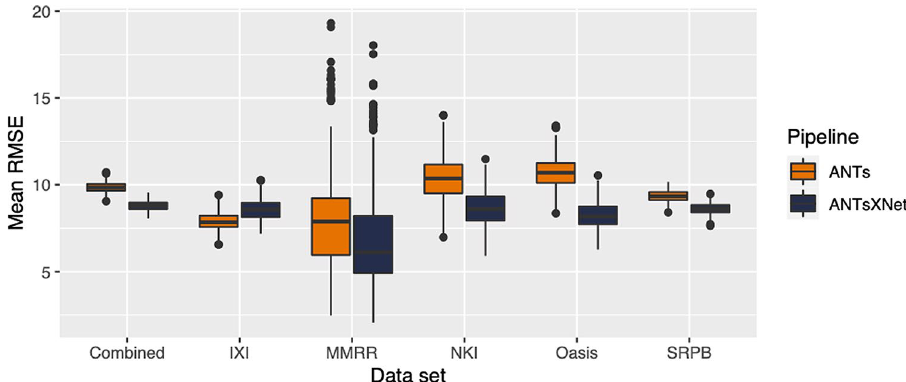
Figure 3. Distribution of mean RMSE values (500 permutations) for age prediction across the different data sets between the traditional ANTs and deep learning-based ANTsXNet pipelines. Total mean values are as follows: Combined—9.3 years (ANTs) and 8.2 years (ANTsXNet); IXI—7.9 years (ANTs) and 8.6 years (ANTsXNet); MMRR—7.9 years (ANTs) and 7.6 years (ANTsXNet); NKI—8.7 years (ANTs) and 7.9 years